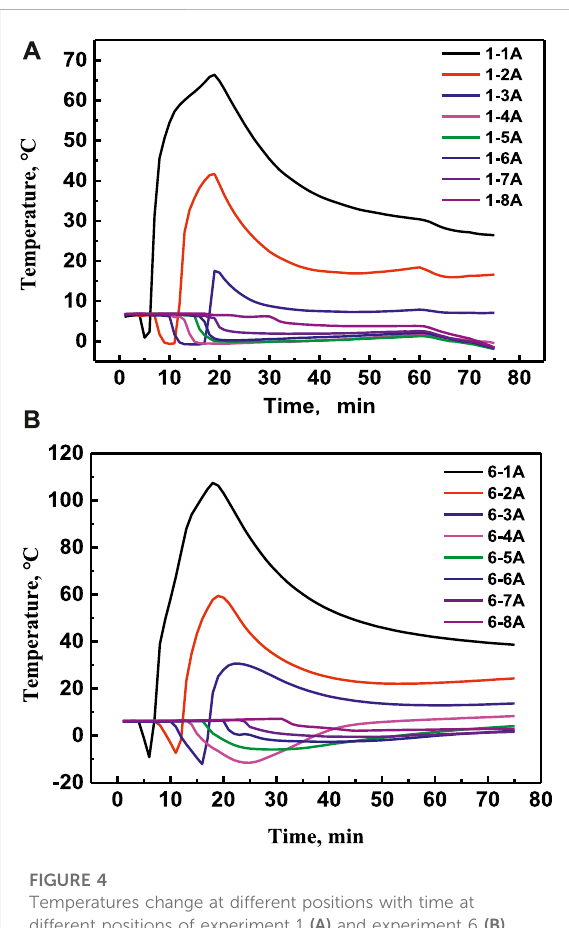
FIGURE 4 Temperatures change at different positions with time at different positions of experiment 1 (A) and experiment 6 (B) ,